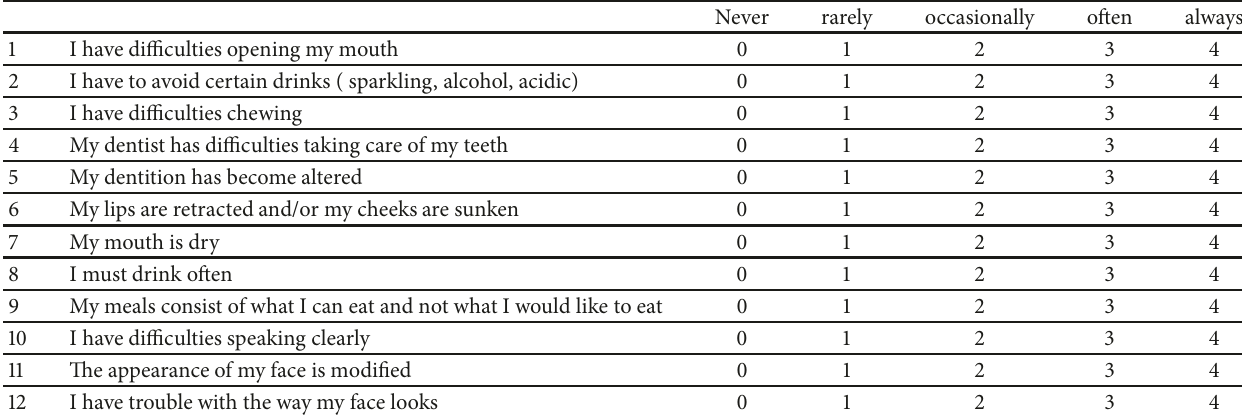
Table 1: The mouth handicap in systemic sclerosis scale